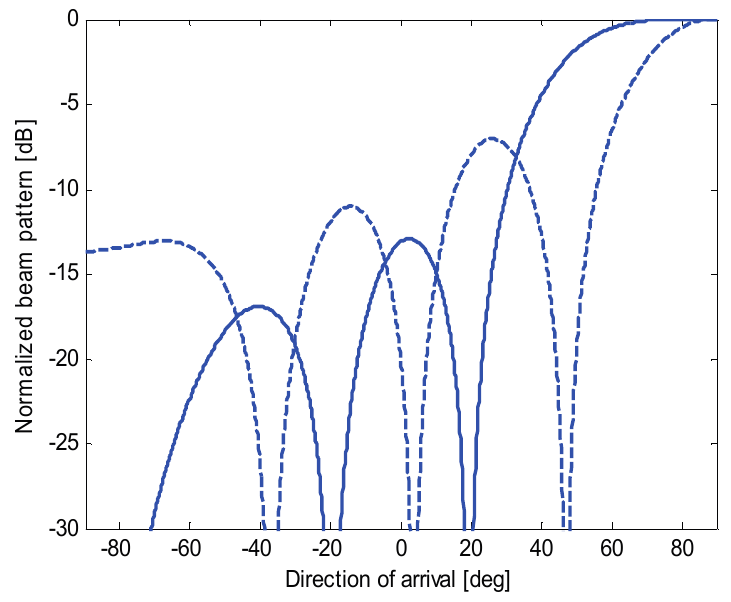
Figure 3. Normalized end-fire beam patterns for an array of 10 sensors with a spacing d = 0.15 λ without oversteering (solid line) and with oversteering (dashed line), using a uniform weighting